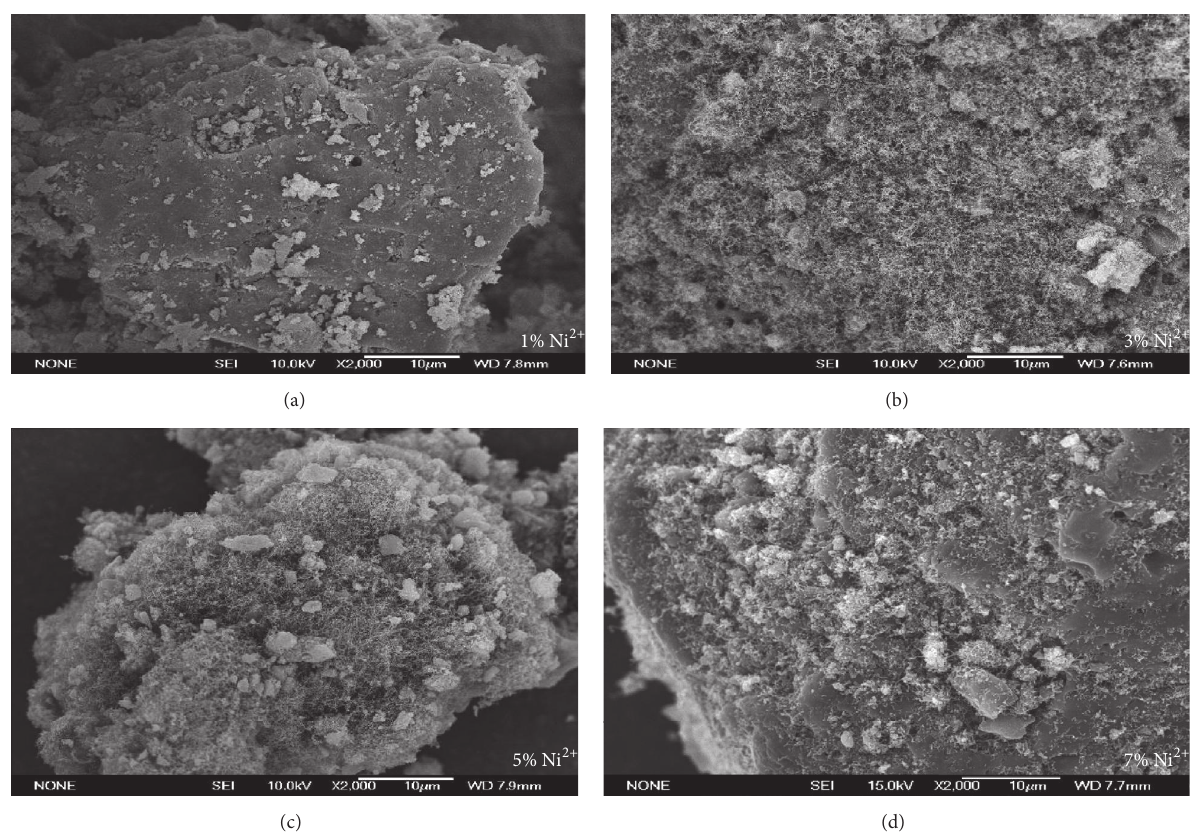
Figure 2: Field Emission Scanning Electron Microscope image of the CNF for (a) 1% catalyst, (b) 3% catalyst, (c) 5% catalyst, and (d) 7%